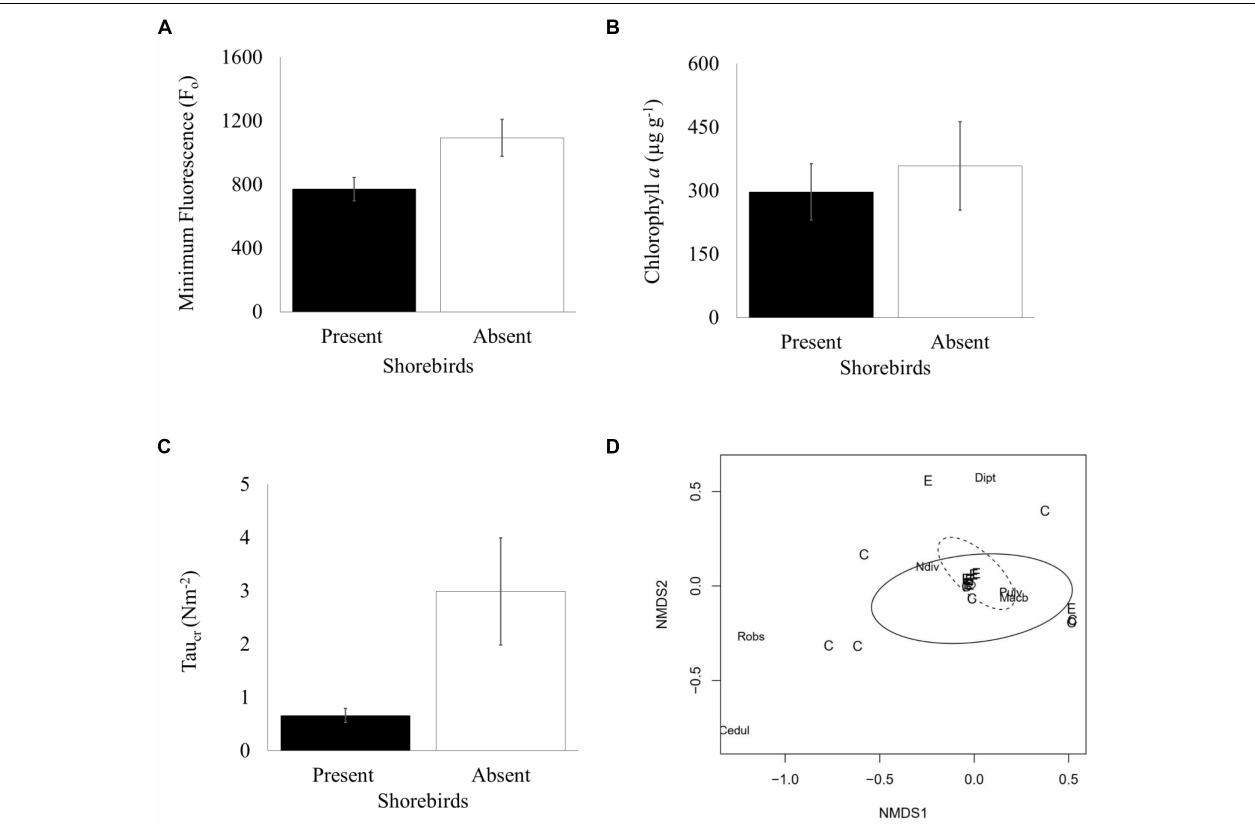
FIGURE 3 | Measured characteristics in shorebird presence/absence on day 45 (06 March 2017) (A) Mean F o ( ± SE, n = 50) (B) Mean chlorophyll a content in top ∼ 2 mm ( µ g g - 1 ) ( ± SE, n = 14) (C) Mean erosion threshold ( τ cr ) ( ± SE, n = 36) (D) Non-metric multidimensional scaling (MDS) plot depicting Bray-Curtis dissimilarity in community composition (shorebird presence = solid oval; shorebird absence = dotted oval, C = shorebird presence, E = shorebird absence, Cedul = C. edule , Robs = R. obtusa , Dipt = Chironomidae, Pulv = P. ulvae , Ndiv = N. diversicolor